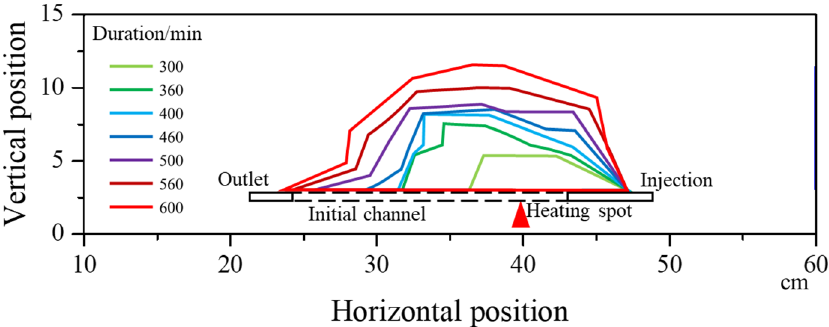
Figure 8. Shape variation of gasification cavity at different stages.